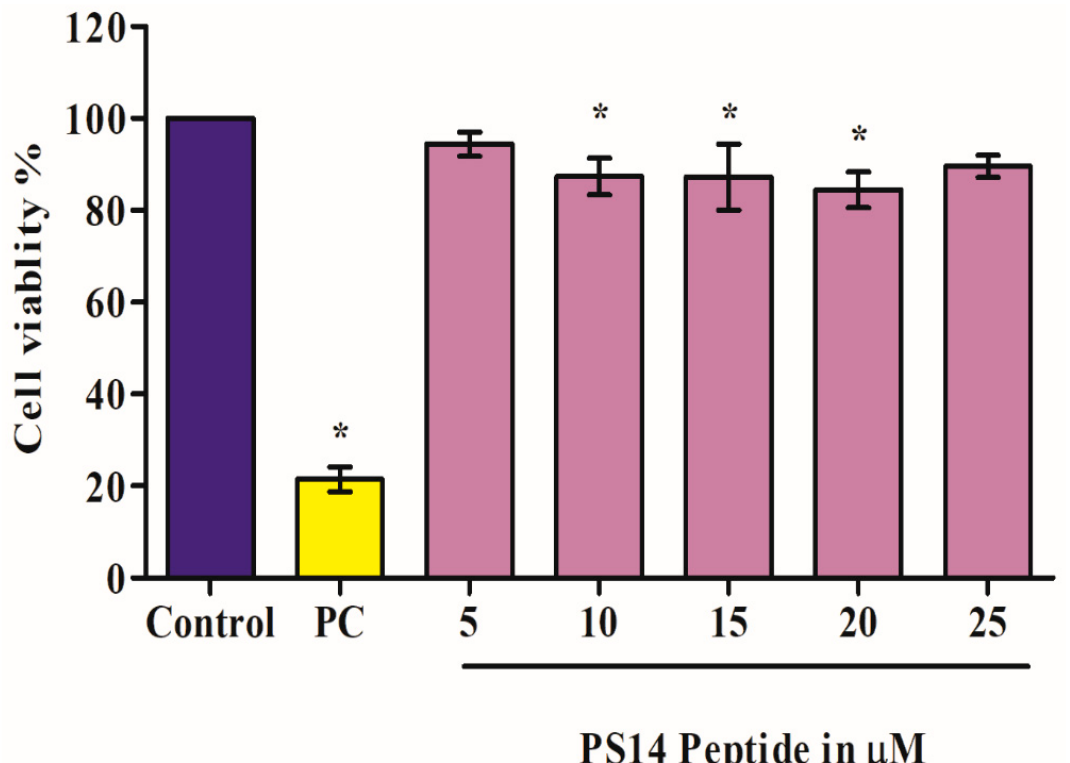
Figure 1. In vitro toxicity of PS14 tested on rat skeletal myoblast cells (L6 cell line) assessed by MTT assay. The bar shows the toxicity values of control (untreated), PC (positive control) Triton X-100 (0.01%) and PS14-treated experimental sample at five different concentrations. The asterix (*) denotes p < 0.05 level of significance compared to the control. Data were presented as mean ± standard deviation (SD) of three independent experiments.